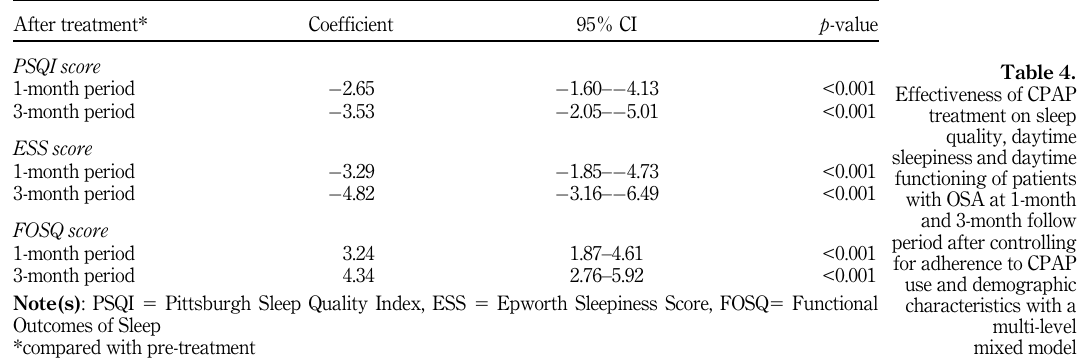
Table 3. Comparison of